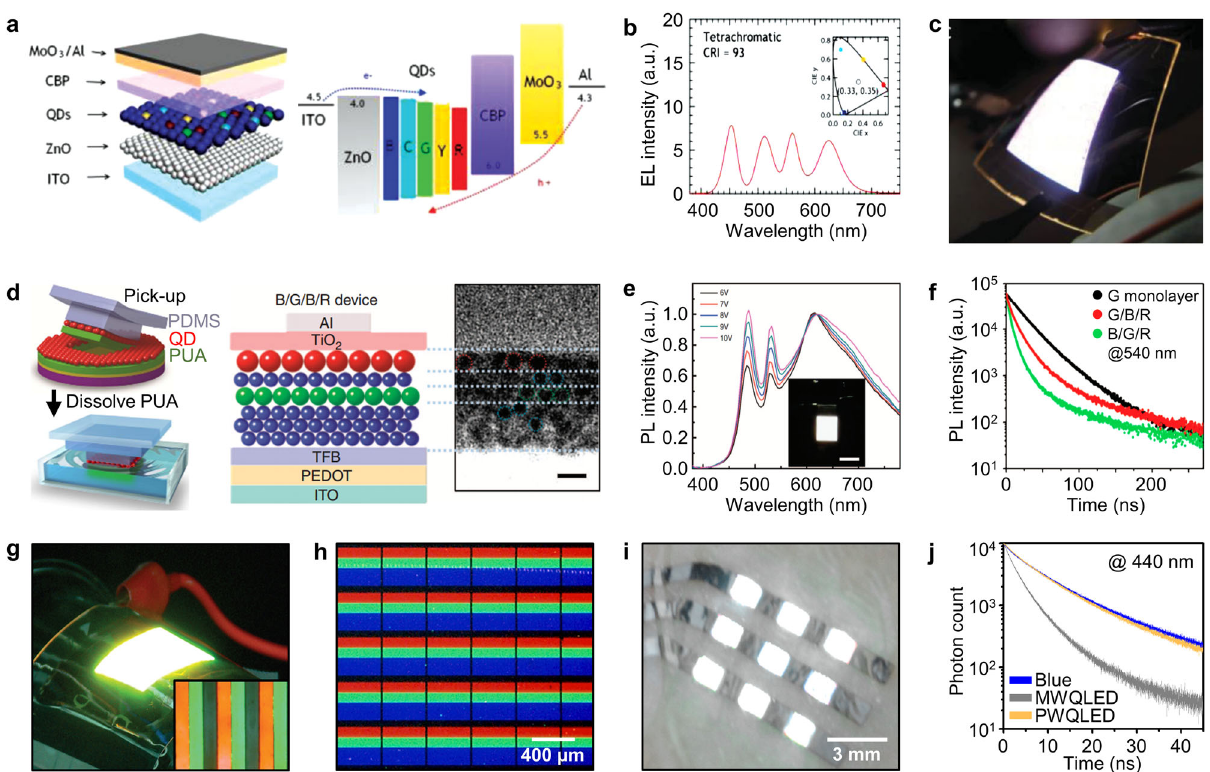
Fig. 5 Flexible white QLEDs. a Device structure (left) and corresponding energy diagram (right) of a white QLED with mixed RGB QD emitting layers. b , c EL of fl exible white QLEDs ( b ) and corresponding EL spectra ( c ). d Scheme illustrating the transfer-printing process for a QD monolayer. Structure of white QLED with multiple stacked QD layers and corresponding cross-sectional TEM image. Scale bar, 10 nm. e PL spectrum of B/G/B/R white QLEDs under various applied voltages. f TRPL decay of multistacked QD fi lms with different layer structures. g Flexible white QLED with RGB patterns prepared using pick-and-release transfer printing. Inset shows the RGB pixels of the white QLED. h RGB patterns for white QLEDs using intaglio transfer printing. i Ultrathin white QLED array attached to human skin. j TRPL spectra of a blue QD layer and white QLEDs composed of RGB pixels (pixelated white QLED; PWQLED) and mixed QD layer (MWQLED). Figure reproduced with permission from: a – c ref. 109 © 2014 Wiley; d – f ref. 111 © 2013 NPG; g ref. 97 © 2011 NPG; h – j ref. 99 © 2015 NPG